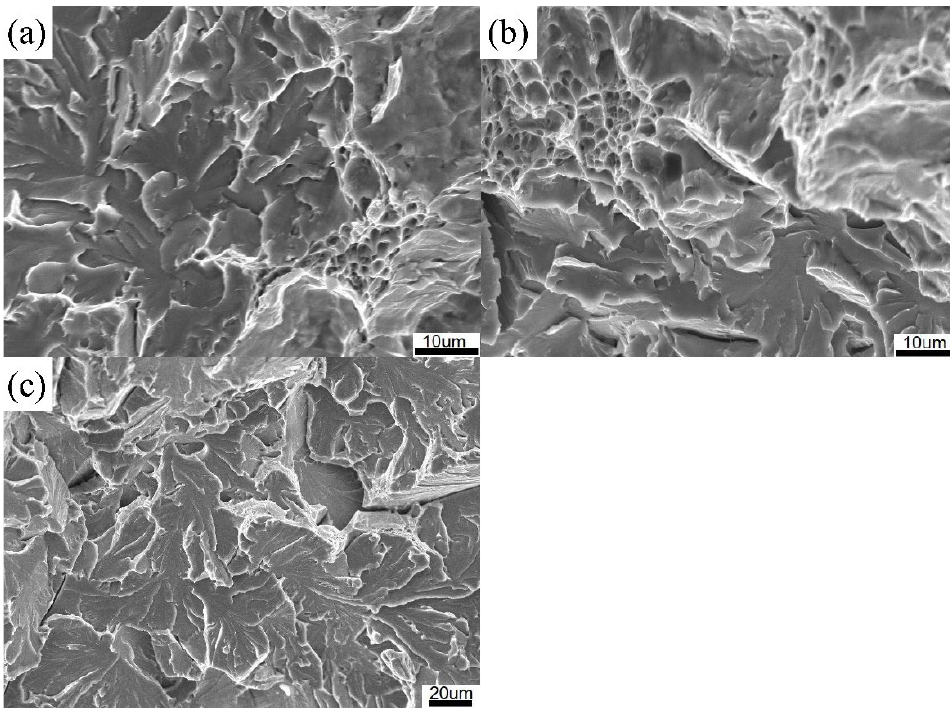
Figure 7. Fracture morphologies of the X80 heavy-wall heat-induced seamless bend at − 60 °C: ( a ) S1, ( b ) S2, and ( c ) S3.